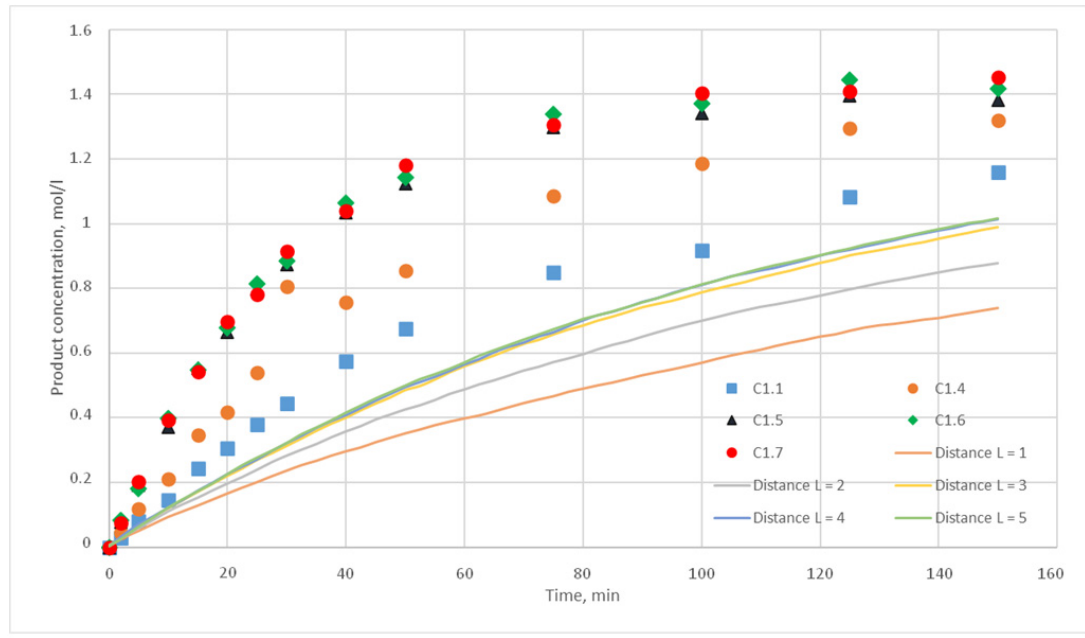
Figure 15. Calculation and experimental reaction kinetic curves. Reaction probability p = 0.005. Lines—calculation curves, points—experimental data.